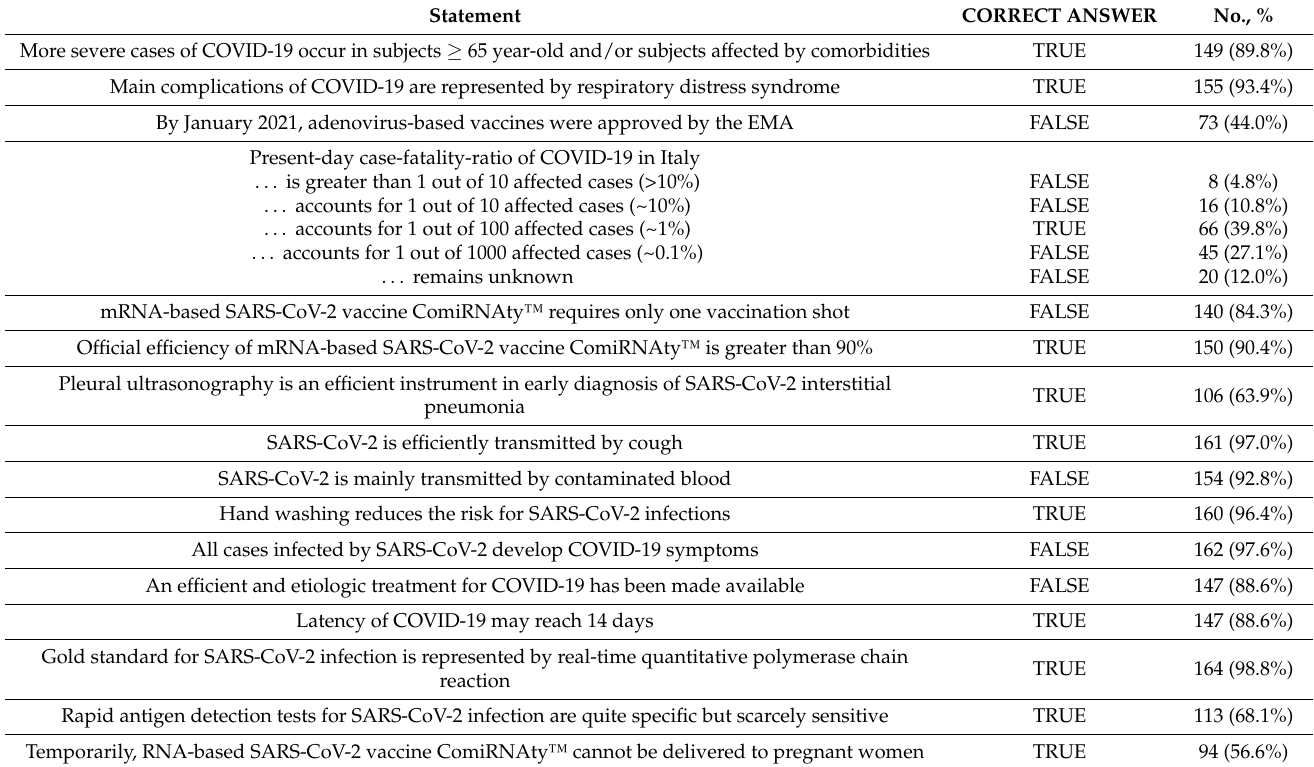
Table 2. Knowledge test: response distribution of the presented items proposed to the 166 occupational physicians participating in the survey and contributing to the assessment of the general knowledge score (GKS) (Cronbach’s Alpha = 0.717).